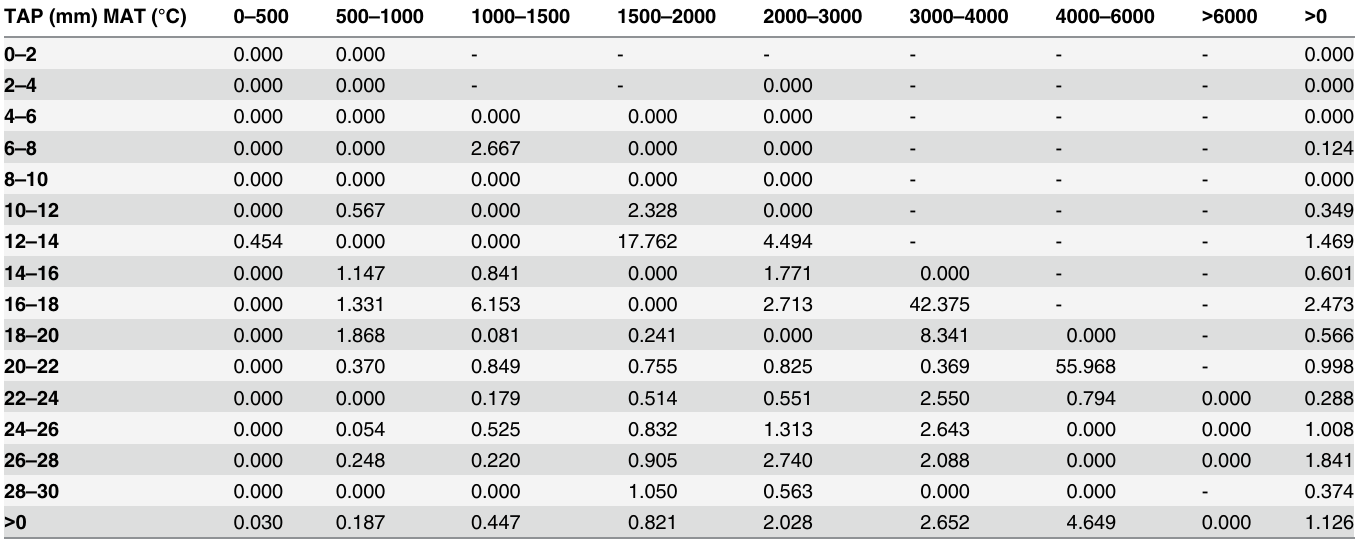
Table 5. The density of census plots (No. plots / 10000 km2) in areas under different climatic conditions as defined by current Total Annual Precipi- tation (TAP) and Mean Annual Temperature